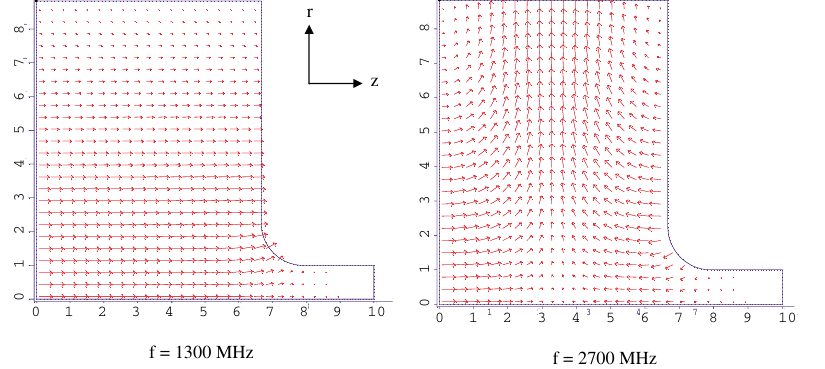
FIG. 4. (Color) Two modes for the same rf cavity. Plot axes are r (radius) versus z (axial) coordinates; all units are in centimeters. The arrows represent the direction and strength of the electric field in the